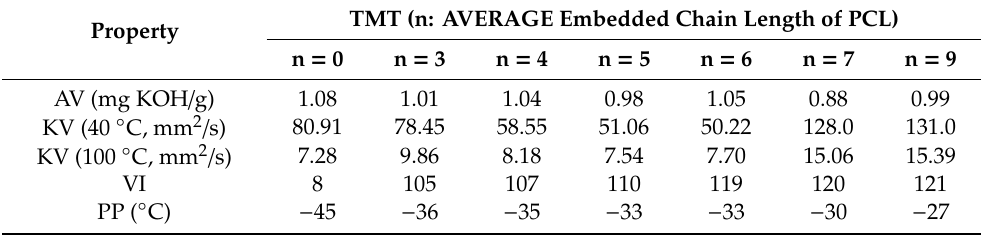
Table 1. E ff ect of embedded chain length on TMT lubrication performance.